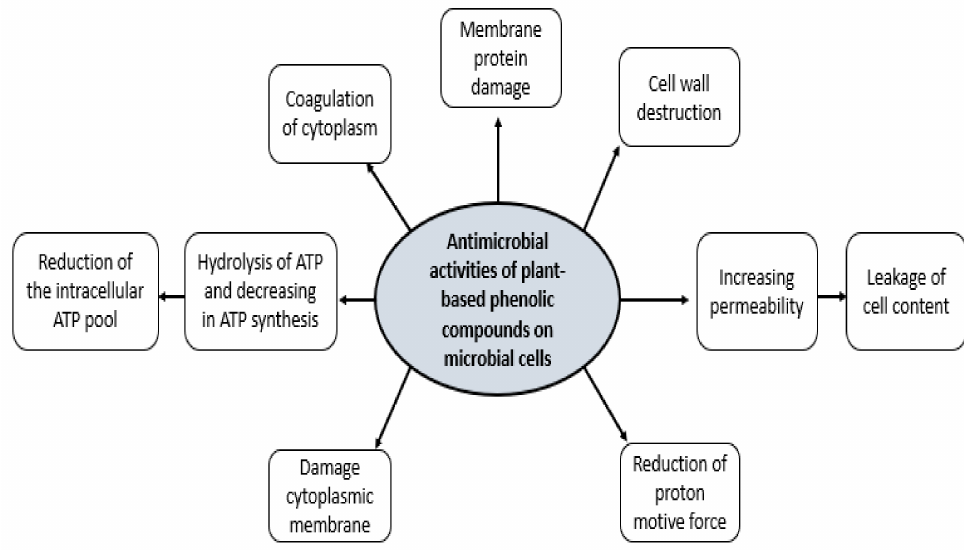
Figure 3. Antimicrobial activities of plant-based phenolic compound on microbial cells. The OH-group of a phenolic molecule is central to the antimicrobial activity of plant extracts. The OH-group can interact with the cell membrane of microorganism by hydrogen bonding [41]. This causes either the disruption of the membrane structure resulting in loss of cellular content, or the delocalization of electrons inducing the depolarization that impacts on the proton motive force, which decreases the pH gradient across the membrane and the level of the ATP pool, and ultimately leads to cell death. The number of OH-groups on the phenolic ring influences the intensity and severity of the antimicrobial